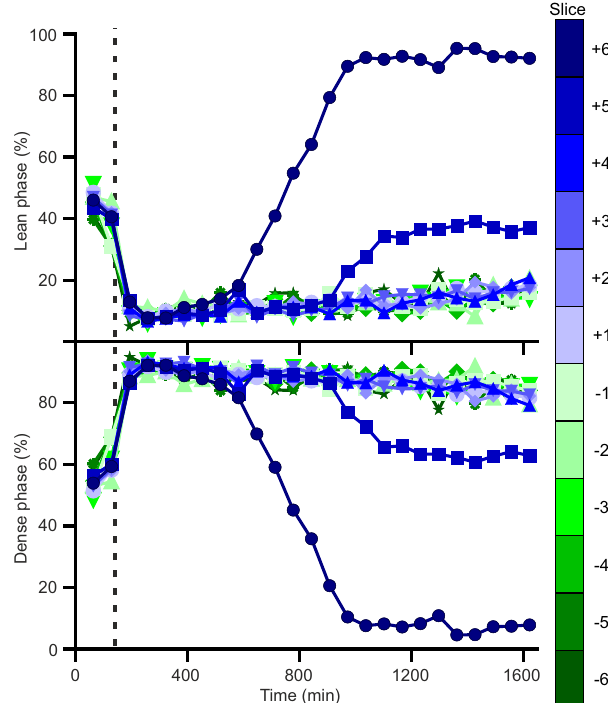
Fig. 6 Slow kinetics of BSA LLPS at 40 °C as characterised by spatially- selective NMR. Lean and dense volumes as percentage of total volume in each slice. Dashed vertical lines denote the onset of layer separation at 140 min, as judged by bulk-detection NMR. Source data are provided as a Source Data fi